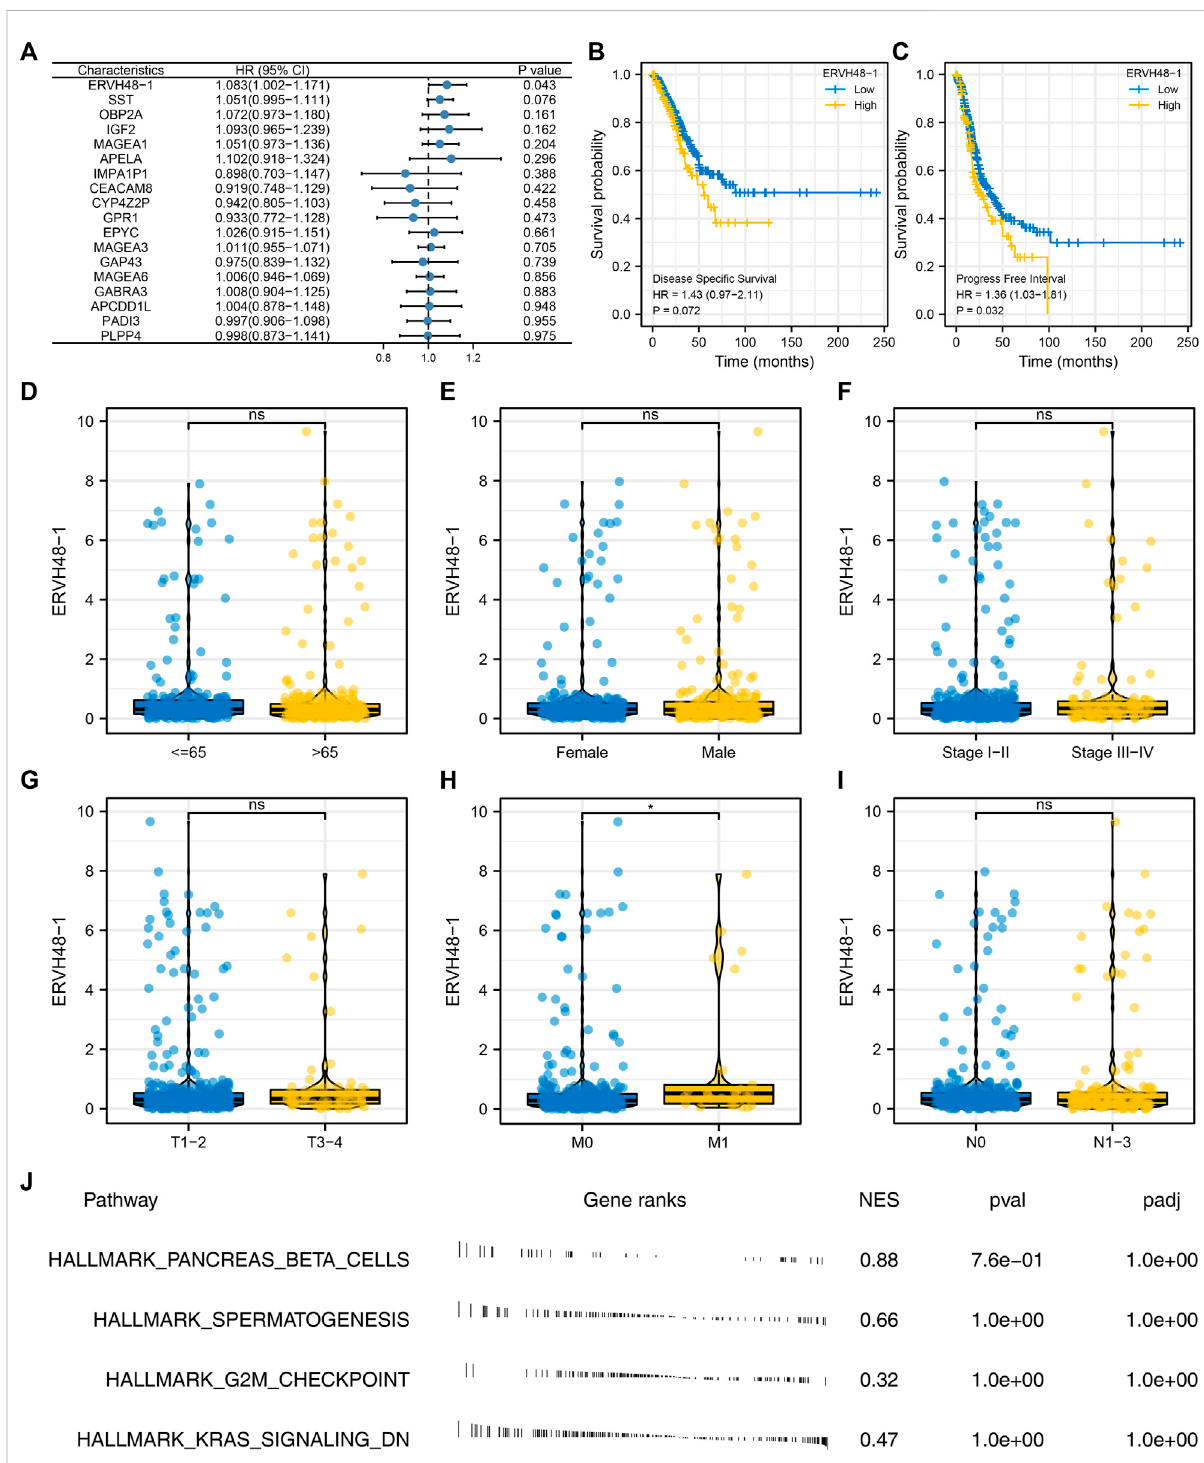
FIGURE 6 Further exploration of ERVH48-1. Notes: (A) Univariate Cox regressionanalysis of the characteristic genes; ( B,C) : Difference in disease-speci fi c survival and progression-free survival in patients with high and low logistics score; ( D – I) : The expression of ERVH48-1 in populations with different clinical characteristics; (J) Pathway enrichment analysis of